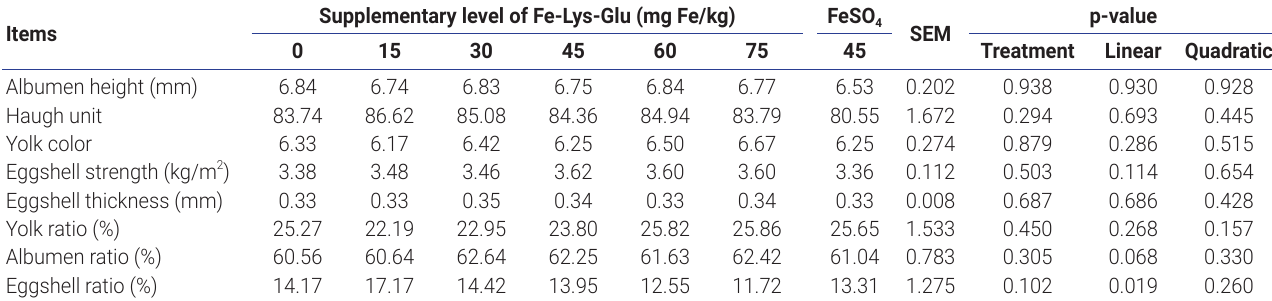
Table 3. Effects of dietary Fe-Lys-Glu supplementation on egg quality of laying hens Items